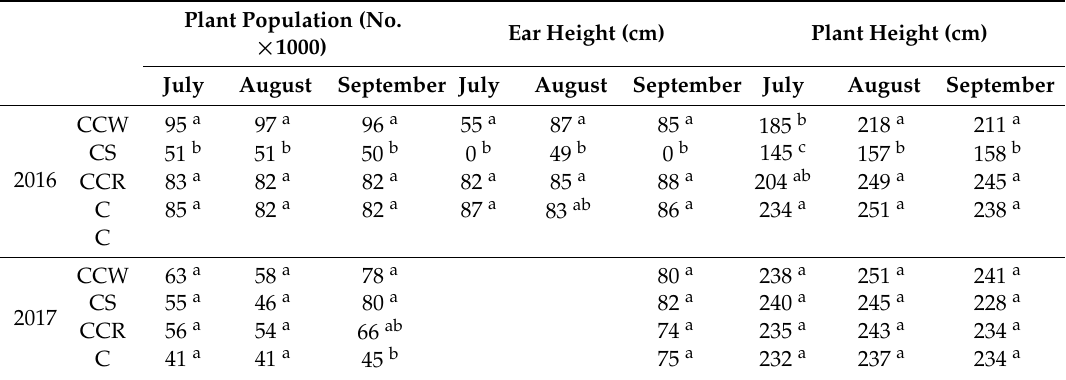
Table 1. Corn agronomic characteristics (plant population, ear height and plant height) of corn grown alone (C), or interseeded with cowpea (CCW), sunn hemp (CS) or crabgrass (CCR). Plant Population (No. Ear Height (cm) Plant Height (cm) × 1000)